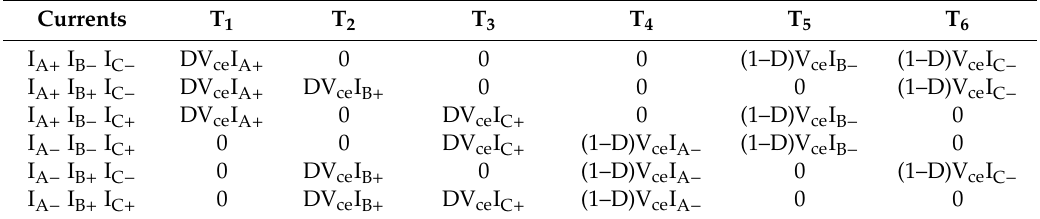
Table 1. Conduction losses of insulated gate bipolar transistors (IGBT) based on the pulse width modulation (PWM) period.